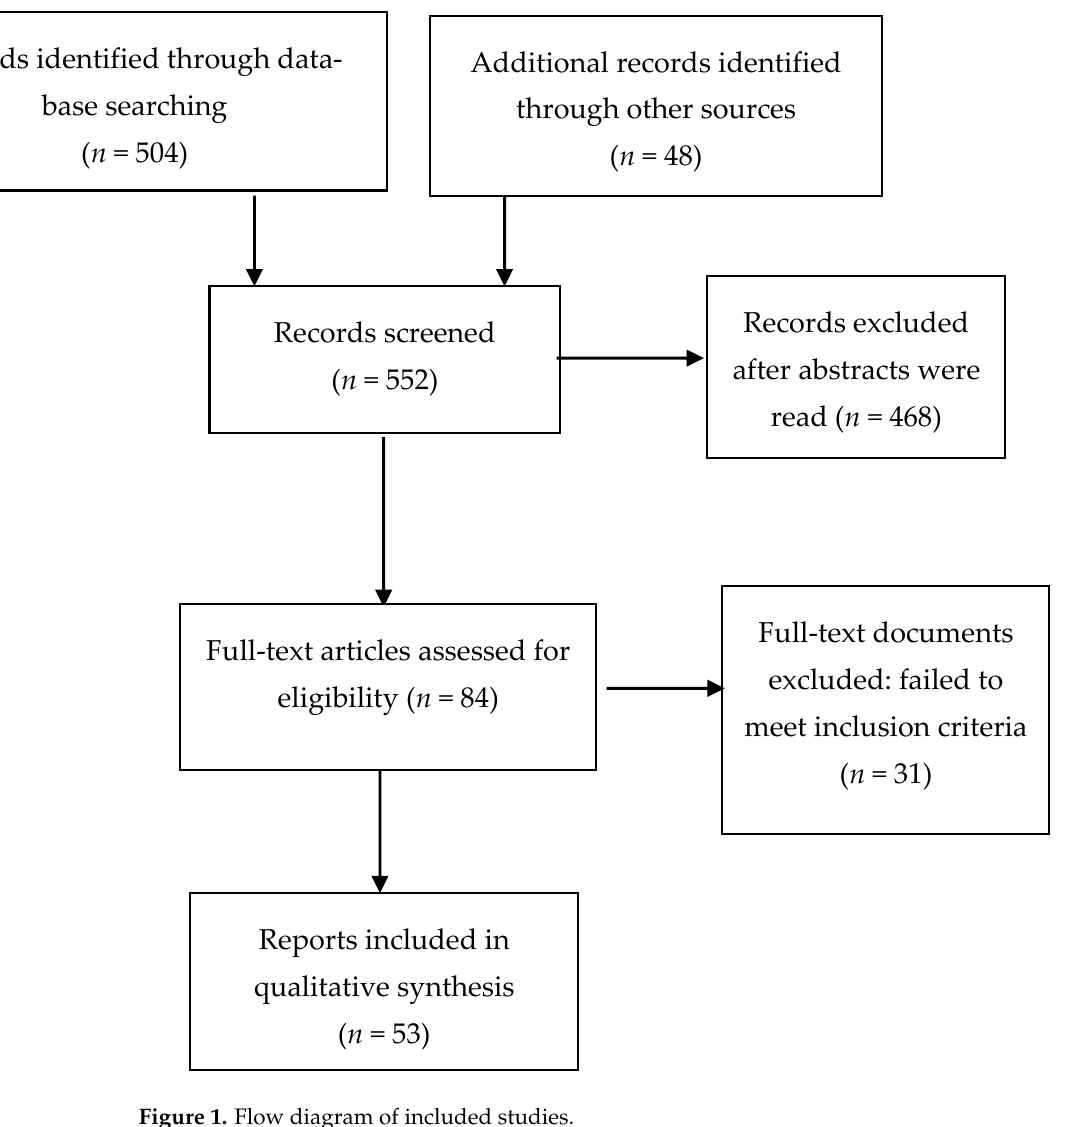
Figure 1. Flow diagram of included studies.